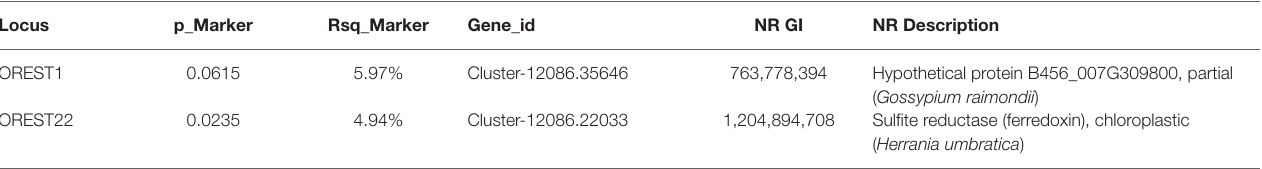
TABLE 3 | Two EST-SSR markers associated with Abelmoschus esculentus fruit color.